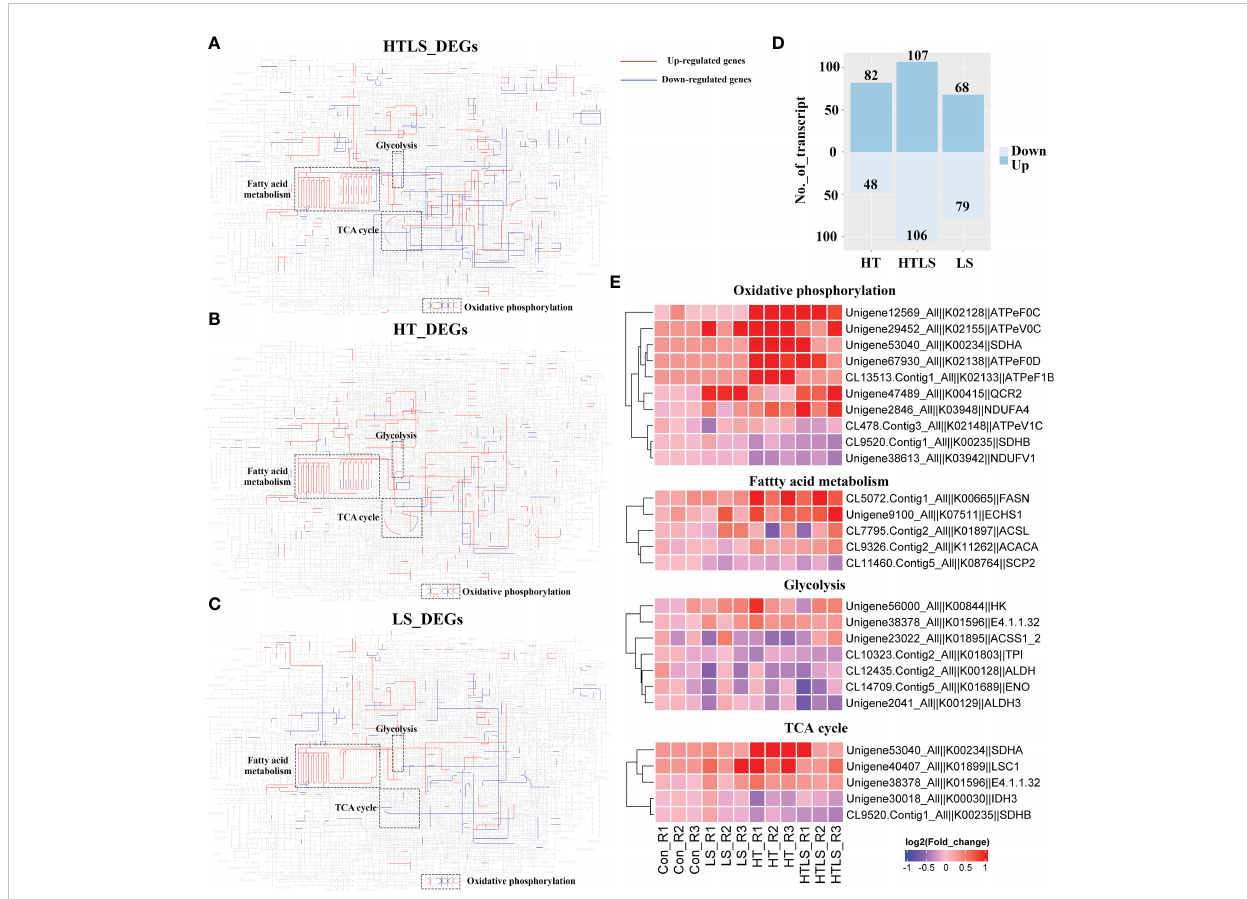
FIGURE 3 Differential expression of metabolic genes in coral larvae under HT, LS and HTLS treatments. The KEGG map of DEGs detected in (A) HT, (B) LS, and (C) HTLS treatment and mapped to KEGG “ Metabolic pathway ” are shown, with highlight of mapped up- and down-regulated DEGs in red and blue respectively, and components involved in “ oxidative phosphorylation ” , “ glycolysis ” , “ TCA cycle ” and “ pentose phosphate pathway ” . The total number of DEGs mapped to “ Metabolic pathway ” is summarized in the bar chart in (D) The heatmap in (E) provides expression pattern of DEGs mapped to “ Metabolic pathway ” in each replicate of each